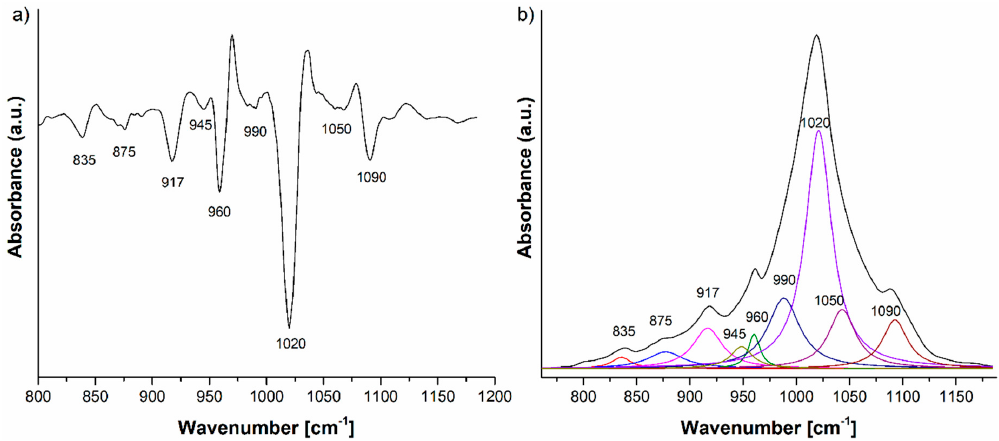
Figure 6. ( a ) Second derivative and ( b ) FTIR deconvoluted spectrum of the HAp-L IR spectrum in the 800–1200 cm − 1 domain.